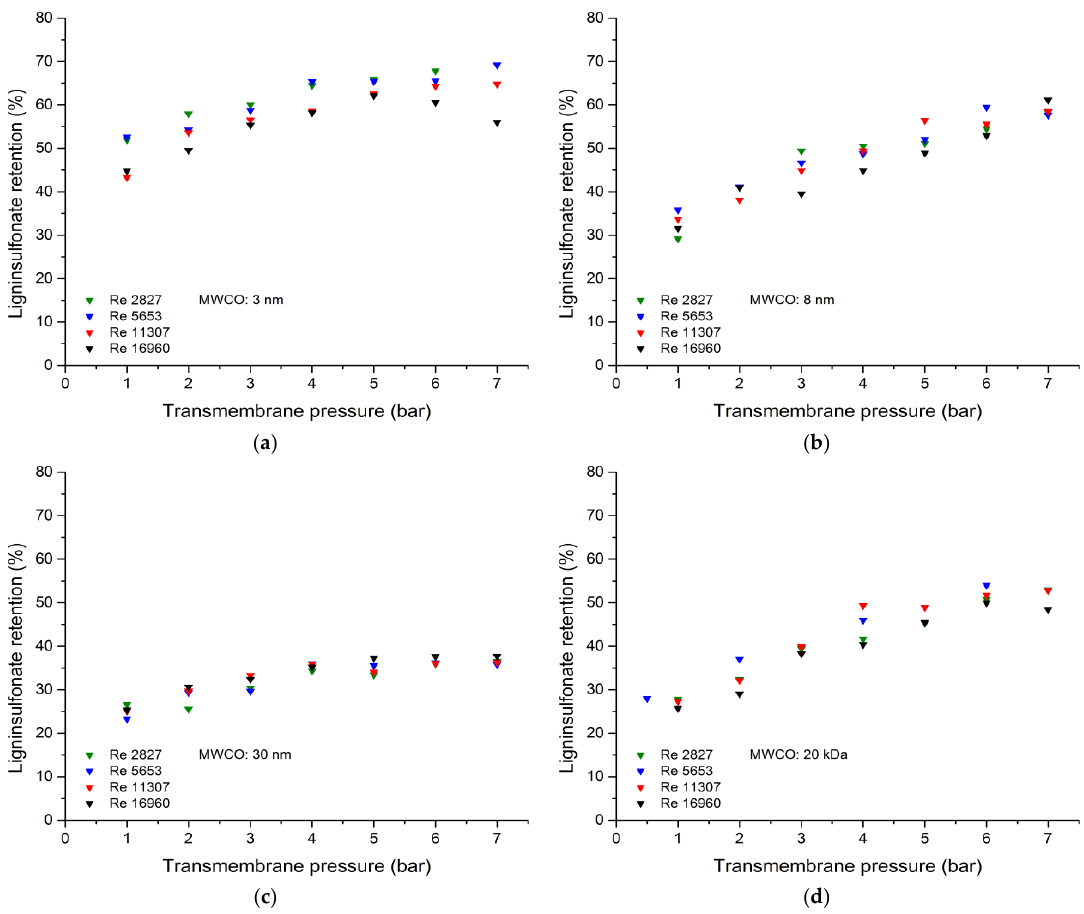
Figure 3. The lignosulfonate retention is dependent on transmembrane pressure during the filtration of spent sulfite liquor at different Reynolds numbers. ( a ) 3-nm ceramic hollow fiber membrane. ( b ) 8-nm ceramic hollow fiber membrane. ( c ) 30-nm ceramic hollow fiber membrane. ( d ) 20-kDa tubular ceramic membrane.